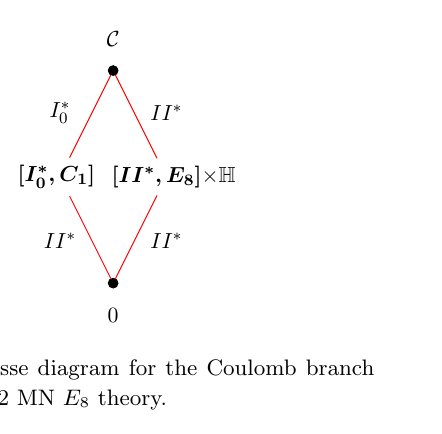
Figure 14. Information about the rank-2 MN E 8